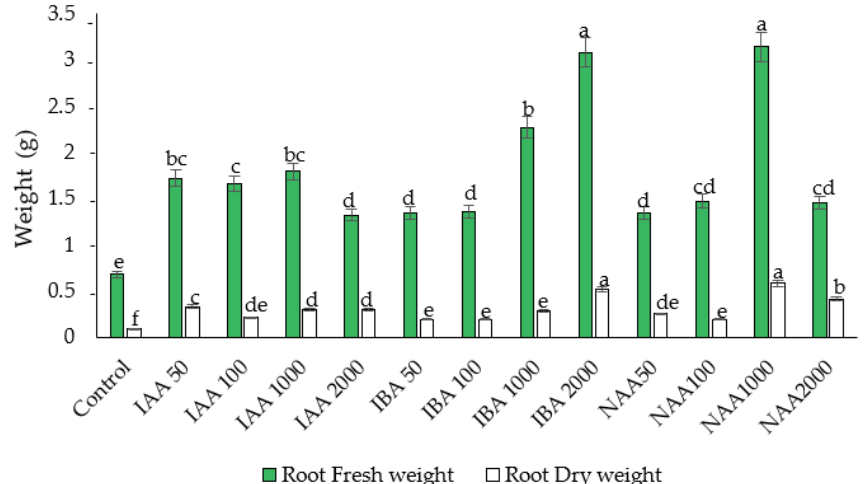
Figure 1. The effect of auxin concentration on root fresh and dry weight in C. indicum. Different letters indicate statistical differences as assessed by Duncan’s multiple comparison tests ( p < 0.05).